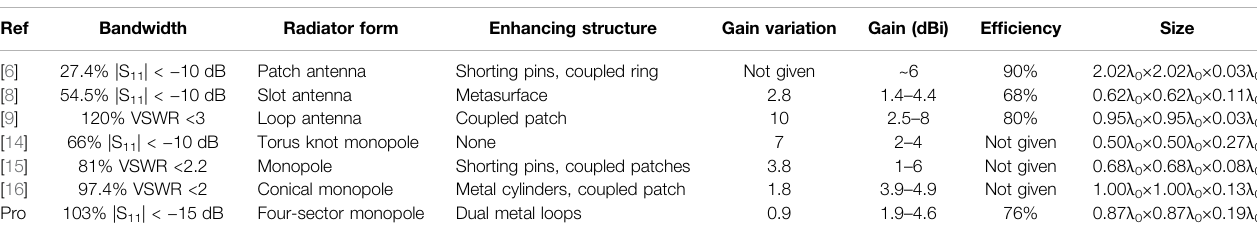
TABLE 2 | Performance comparison of vertically polarized